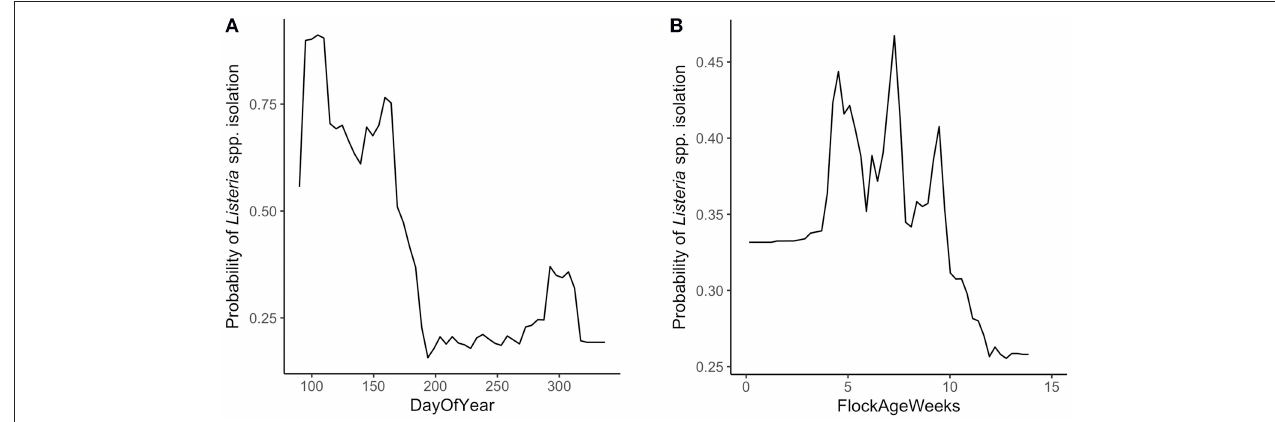
FIGURE 2 | Partial dependency plots (PDPs) for the two most important predictors in the preharvest sample random forest model. (A) DayOfYear represents the day of the year that samples were collected, numerically from 1 to 365. (B) FlockAgeWeeks represents the age of the flock in weeks at the time of sampling.